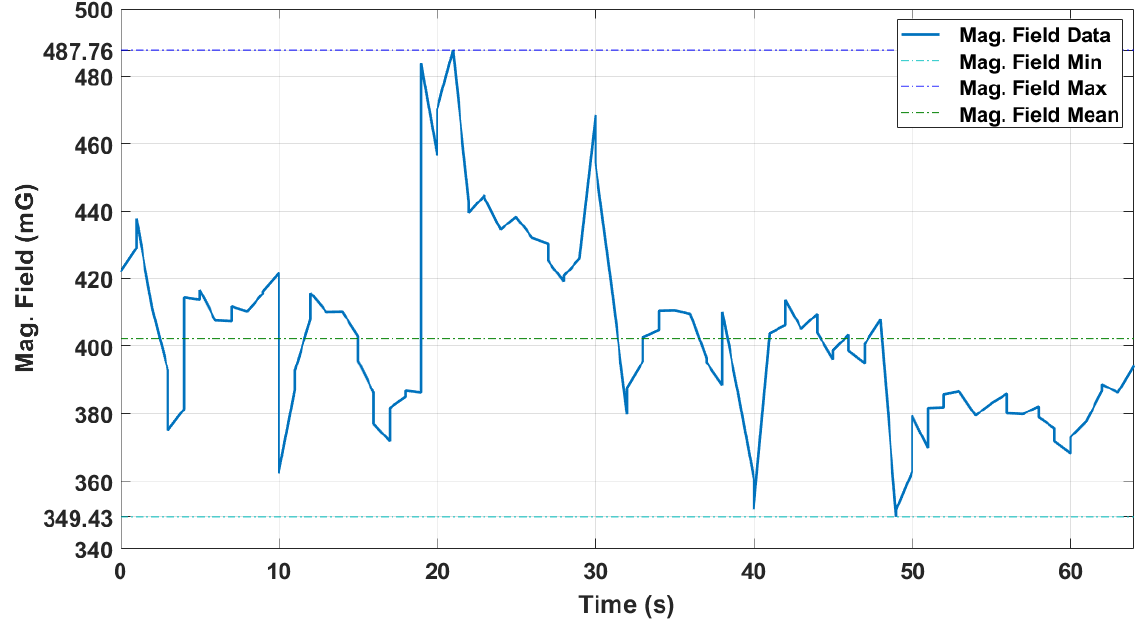
Figure 13. Magnetic field versus time.